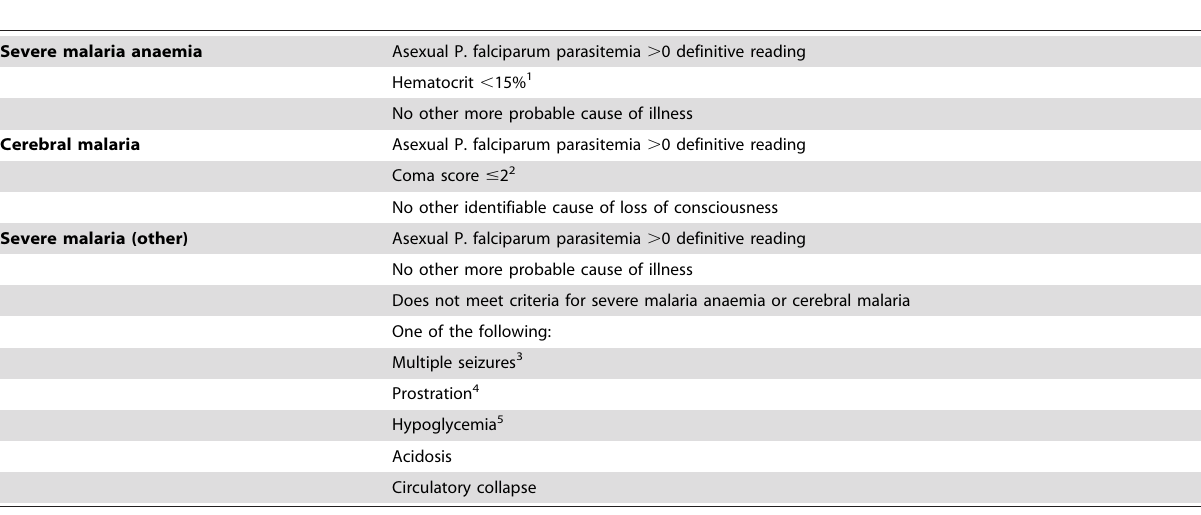
Table 2. Severe malaria definitions for reporting of